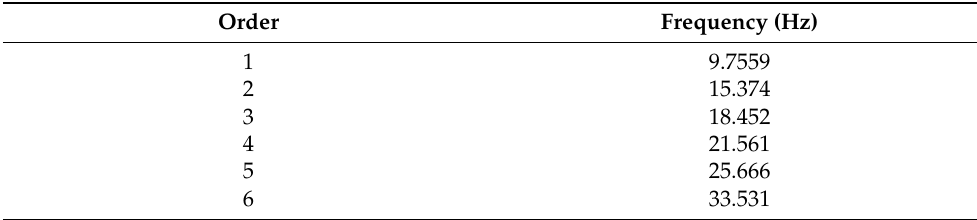
Table 1. First 6 natural